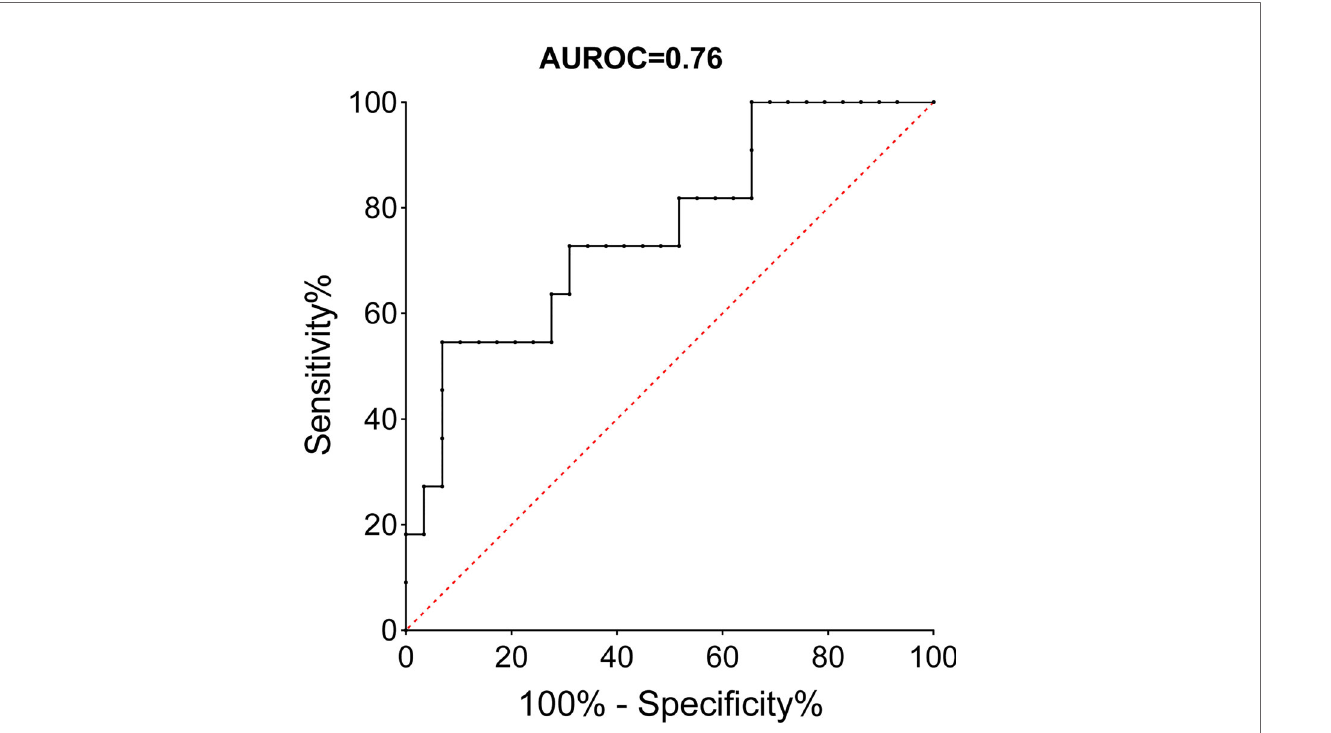
FIGURE 5 | ROC curve of serum IL-33 immediately after reperfusion and MEAF score >6 (LT patients). AUROC, area under the receiver operating